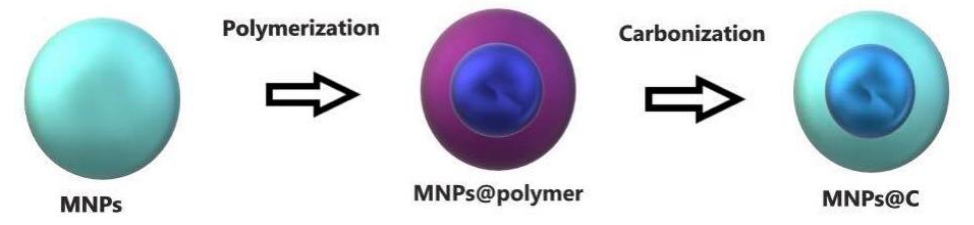
Figure 9. Fabrication process flow of MNP@C.